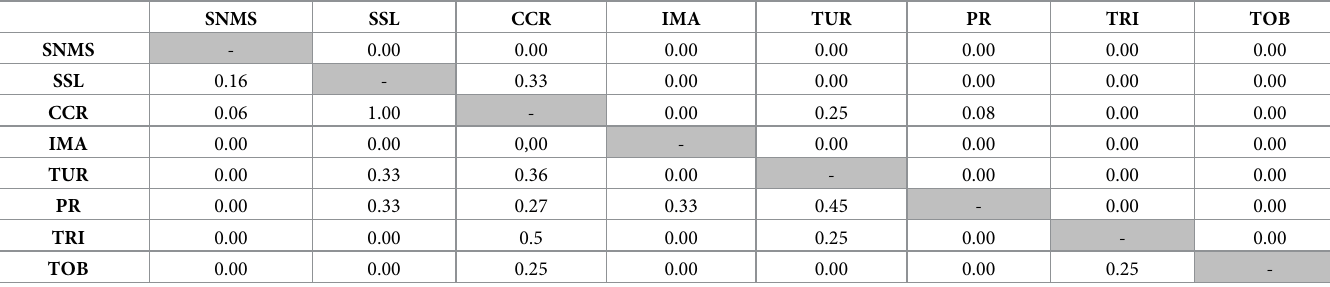
Table 4. Matrix of Simpson´s similarity index of amphibians (top) and reptile (bottom) between all